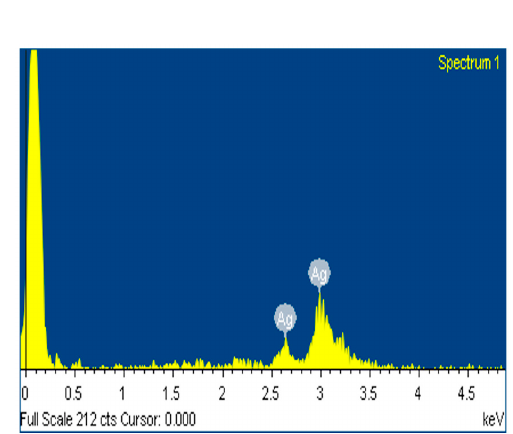
Fig. 3. Scanning Electron Microscopy (SEM) of crude silver nanoparticles